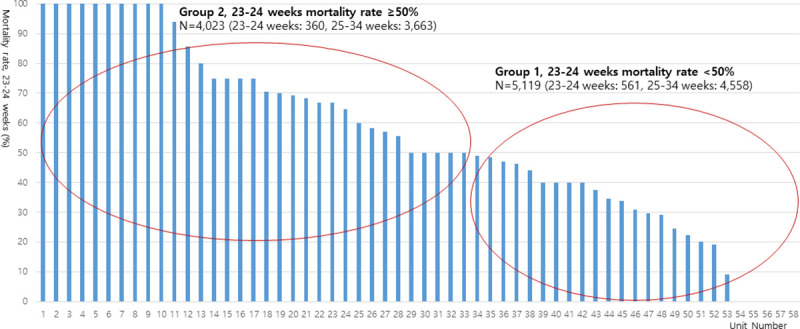
Flowchart showing the study population.This study enrolled 10,399 VLBWI. We excluded 1,257 infants, and these infants were categorized into 2 groups on the bases of their mortality (<50% and ≥50%) at 23–24 weeks of gestation.